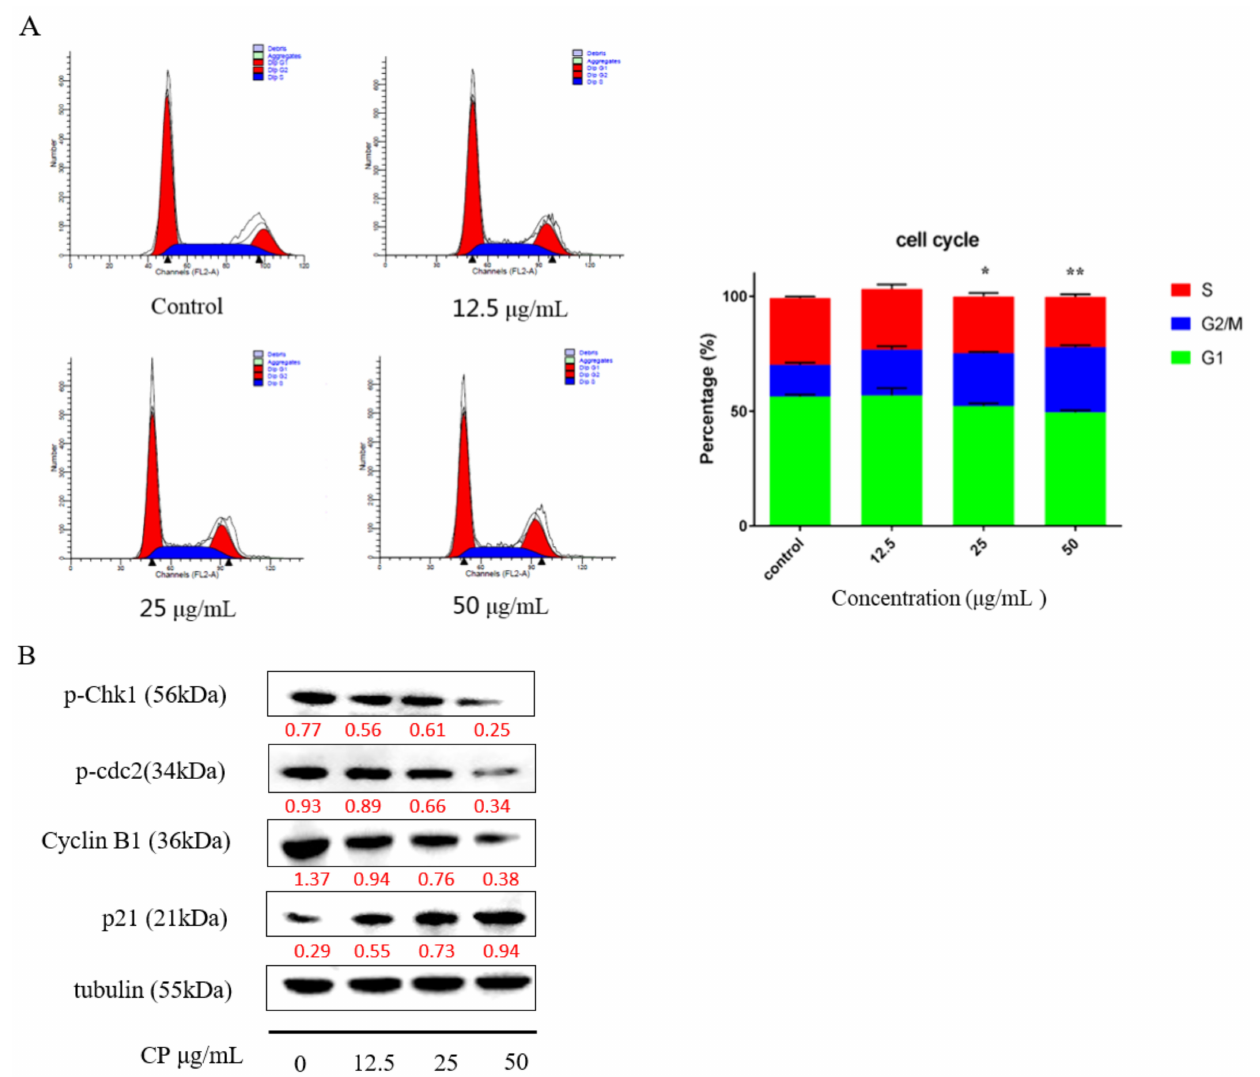
Figure 4. CP promoted G2/M phases cell cycle arrest in Panc-1 cells. ( A ) The cell cycle distribution after CP treatment at the concentration of 12.5, 25, and 50 µ g/mL for 48 h. ( B ) Cell cycle checkpoint protein expression was analyzed by Western blot. Data are presented as mean ± SD; * p < 0.05 and ** p < 0.01 versus control; n =